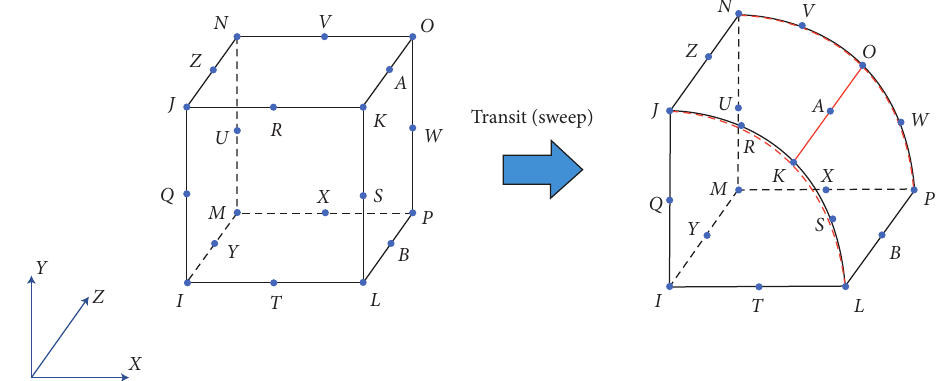
Figure 8: Solid186 element generated by the sweep method.